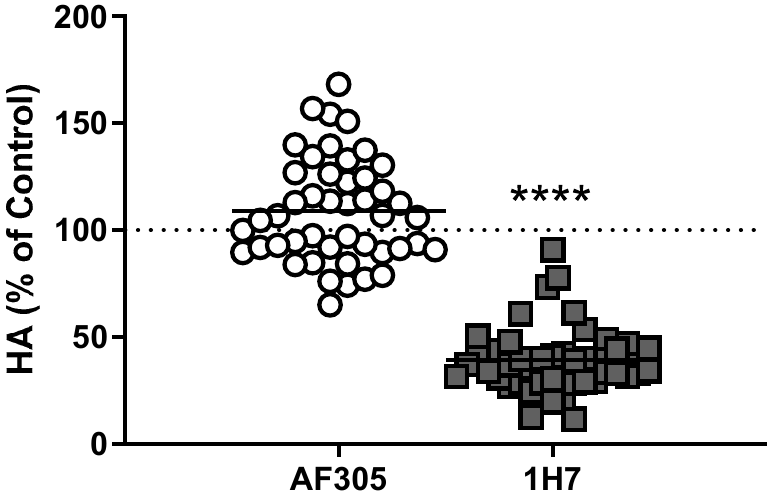
Figure 3. Anti-IGF1R blocking antibodies may or may not inhibit GO-Ig stimulation of hyaluronan secretion by Graves’ orbital fibroblasts. GOFs were stimulated with purified GO-Igs in the presence of IGF1R blocking antibodies, AF305 (white circles) and 1H7 (gray squares). Data were normalized to their own control (dotted line). Each data point represents GO-Igs from one patient, and black bars indicate the averaged means of all stimulatory GO-Igs. Both AF305 and 1H7 completely inhibit binding of IGF1 to IGF1Rs [11] . While AF305 had no effect on GO-Ig stimulation of hyaluronan (HA) secretion, 1H7 partially inhibited GO-Ig stimulation of HA secretion. These findings are consistent with the idea that AF305 does not affect TSHR/IGF1R crosstalk, whereas 1H7 inhibits crosstalk. Reprinted from [11] . **** P < 0.001 vs. GO-Ig control by Student’s t-test.